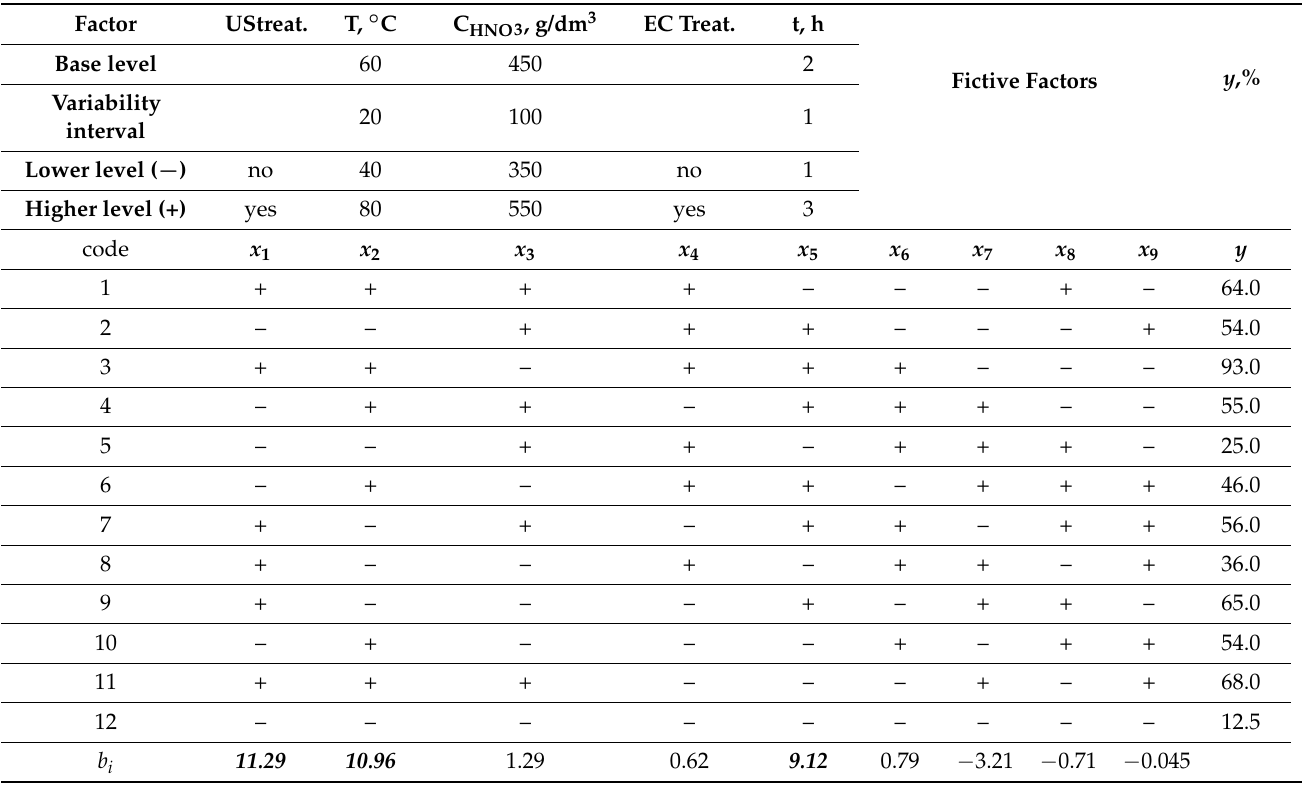
Table 10. Screening experiment